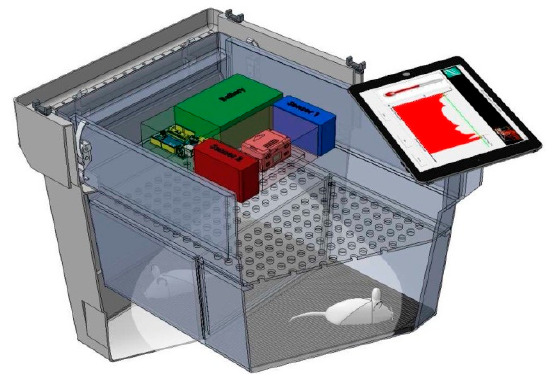
Figure 2. Prototype design of the transport box.